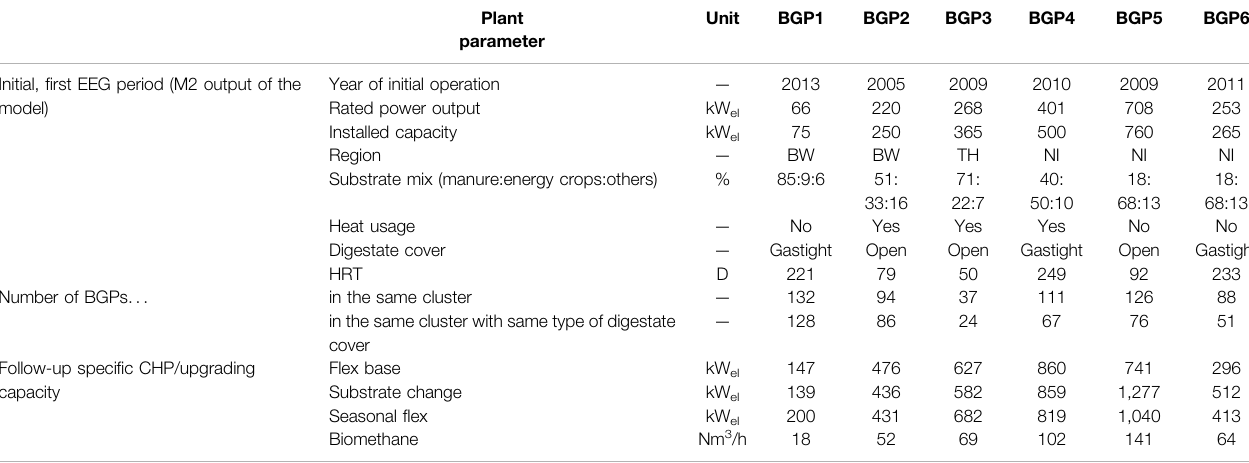
TABLE 4 | Main parameters of the reference biogas plants (BGPs) determined for the initial, fi rst EEG period and the follow-up concepts in the REF scenario. Plant